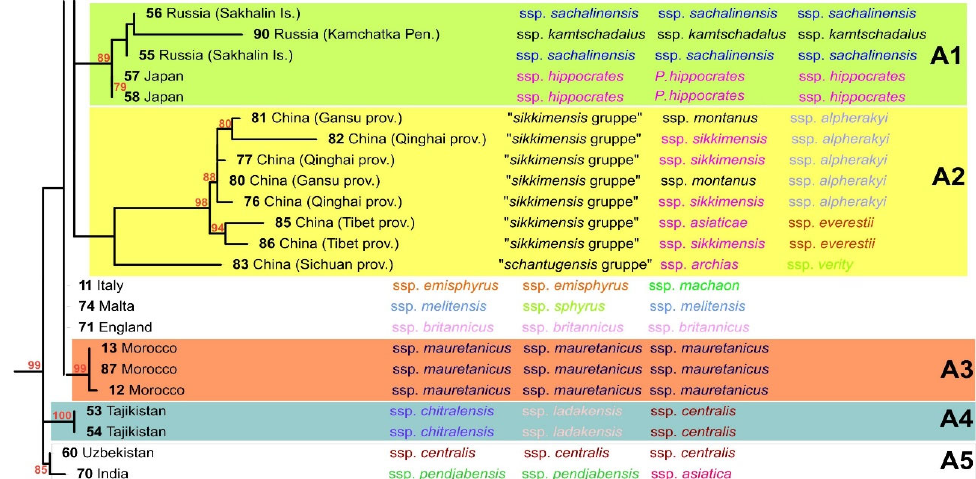
Figure 5. The part of the maximum-likelihood tree (Figure 4) derived from a combination of 16S rDNA and cytochrome b sequences. Bootstrap values over 70% are shown next to the branches. The scale bar showed the number of substitutions per site. The individuals on the tree are related to subspecies according to approach of Eller [1] (first column), Seyer [2,7–9] (second column) and Sturm [3] (third column).